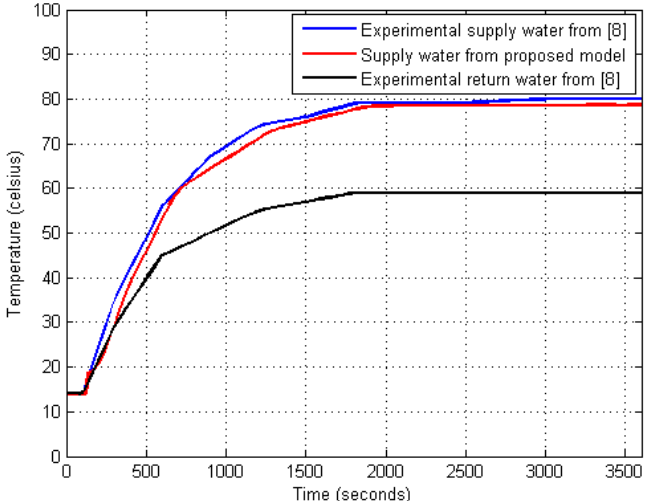
Figure 5. Effect of supply and return water (inlet) temperature as a function of